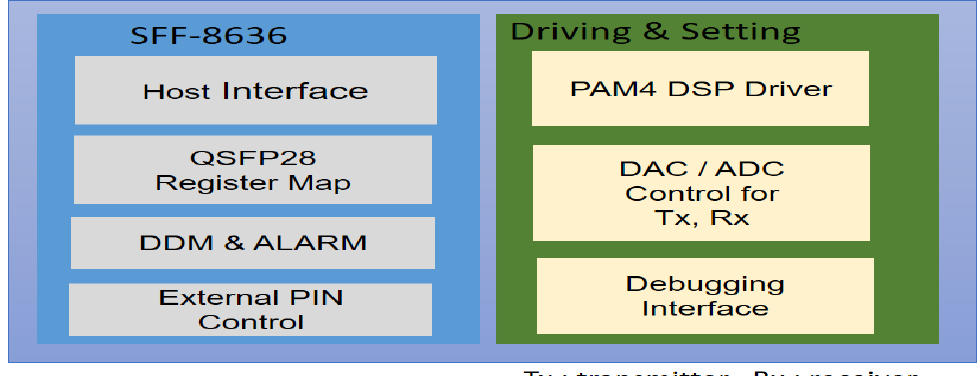
Figure 6. QSFP28 firmware function design block